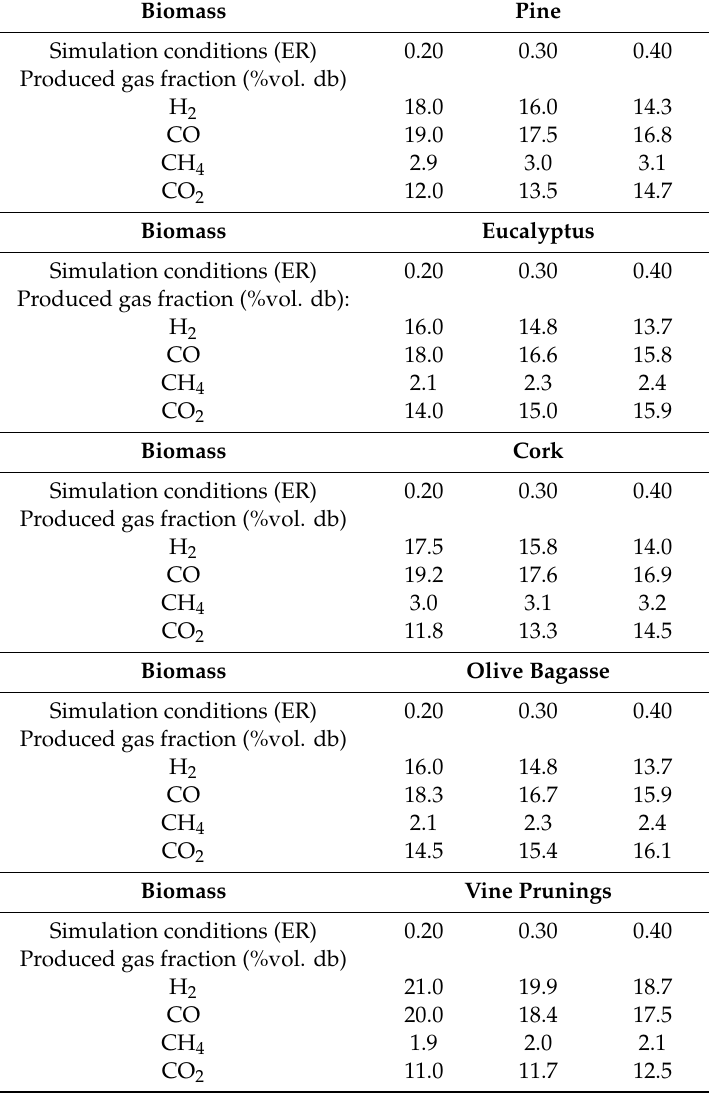
Table 7. Model results for various Portuguese biomasses.